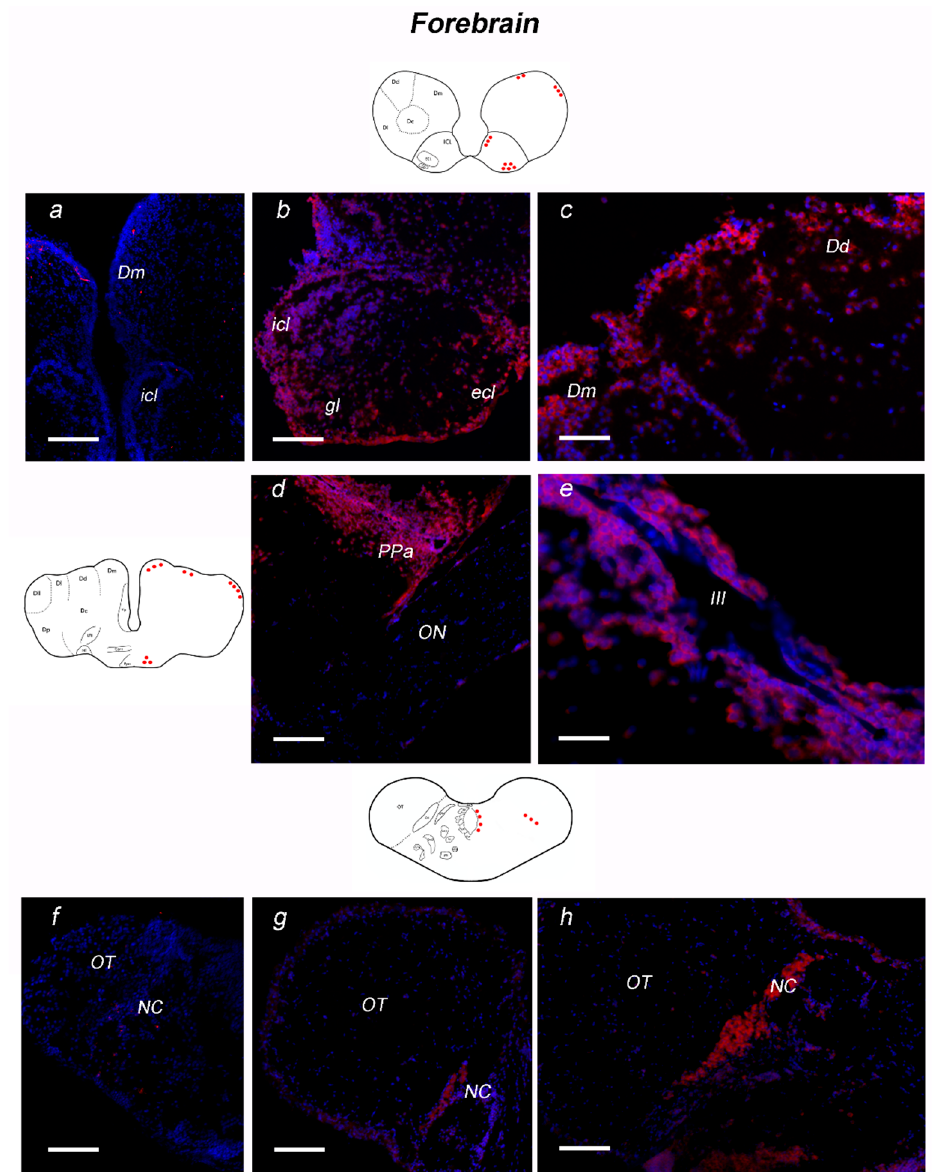
Figure 5. Expression of neurotrophin-6 (NT-6) mRNA in transverse section of forebrain of adult N. furzeri. On the left side, schematic drawings of N. furzeri brain, with red dots indicating NT-6 mRNA distribution over the different brain areas. Forebrain: ( a ) sense probe staining in the Dm and OB; ( b ) positive cells in icl, ecl and gl of olfactory bulbs; ( c ) positive neurons in the dorso-medial and dorso-dorsal zone of dorsal telencephalon; ( d ) numerous and intensely stained neurons in the anterior part of preoptic area; ( e ) intensely stained neurons scattered along the third ventricle; ( f ) sense probe staining in the NC and anterior part of OT; ( g ) overview of pretectal area and anterior part of optic tectum, with strong positive labeling in the neurons of NC; and ( h ) high magnification of positive neurons of NC. Scale bars: ( a – c , f ) 50 µ m; ( d ) 25 µ m; and ( e ) 100 µ m. Abbreviations: Dd, dorsal zone of dorsal telencephalon; Dm, medial zone of dorsal telencephalon; ecl, external cellular layer; gl, glomerular layer; icl, internal cellular layer; NC, cortical nucleus; OB, olphactory bulb; ON, optic nerve; OT, optic tectum; PPa, anterior preoptic area; III, third ventricle. Midbrain